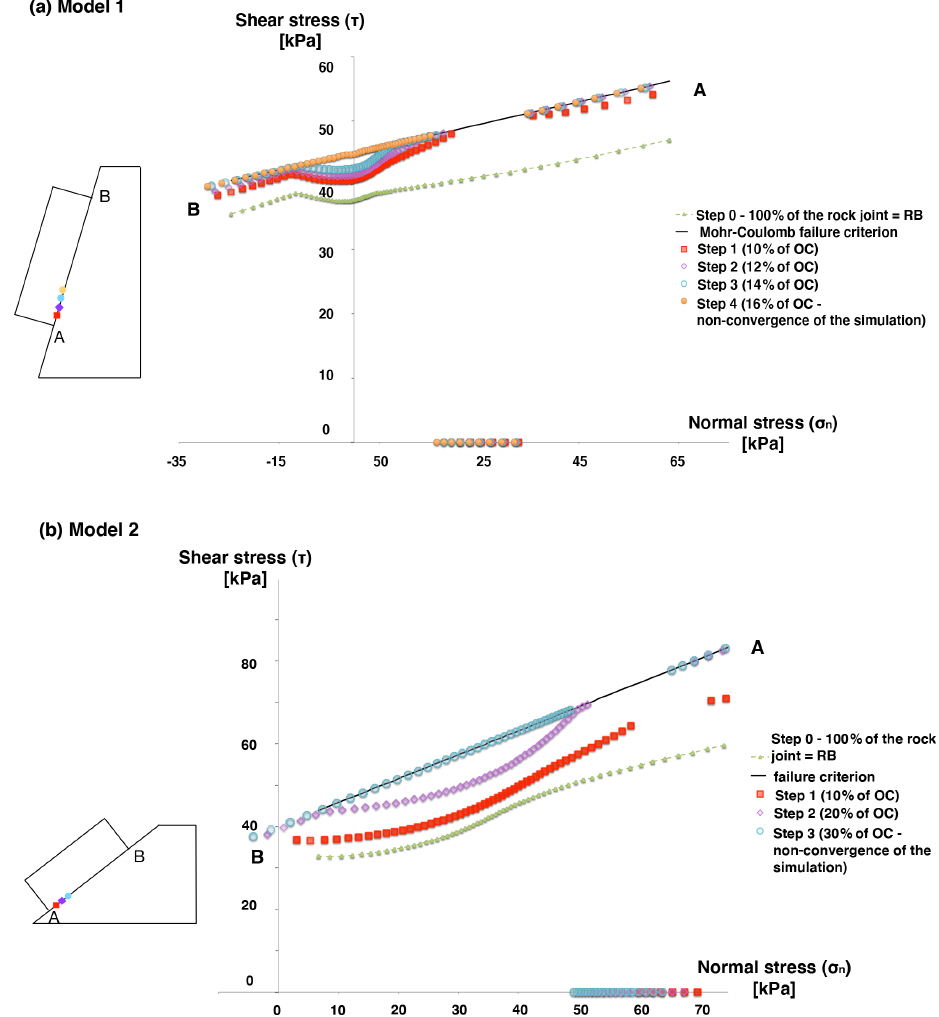
Figure 4. Distribution of the normal and shear stresses for models 1 and 2 considering Scenario 1. The different steps represent the introduc- tion of new OC contacts until the model does not converge anymore. The points on the x axis have normal stress but no shear stress as if the friction angle were zero. Each colour between point A and point B in the model corresponds to the step presented in the